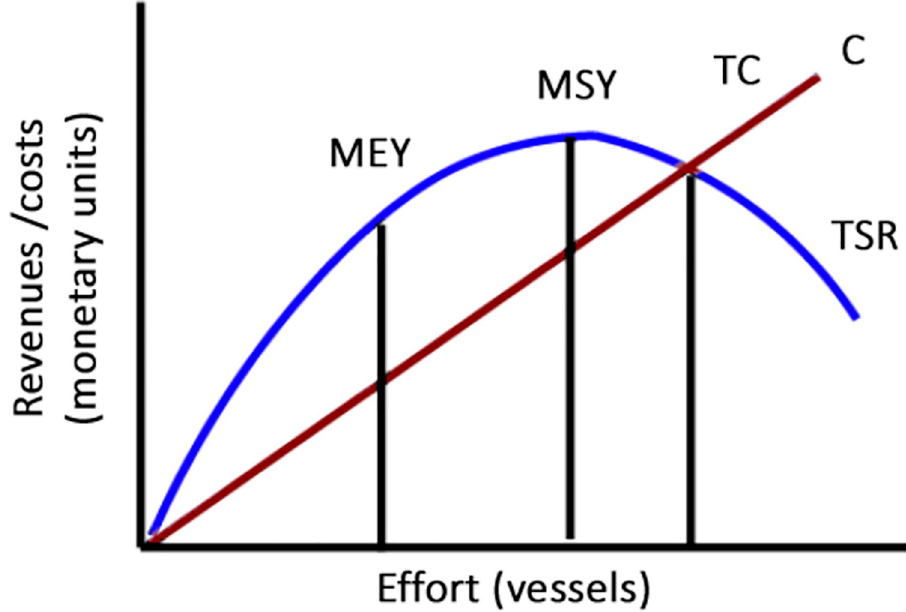
Fig 1. Gordon-Schaefer model. Own elaboration based on Seijo et al. [20].